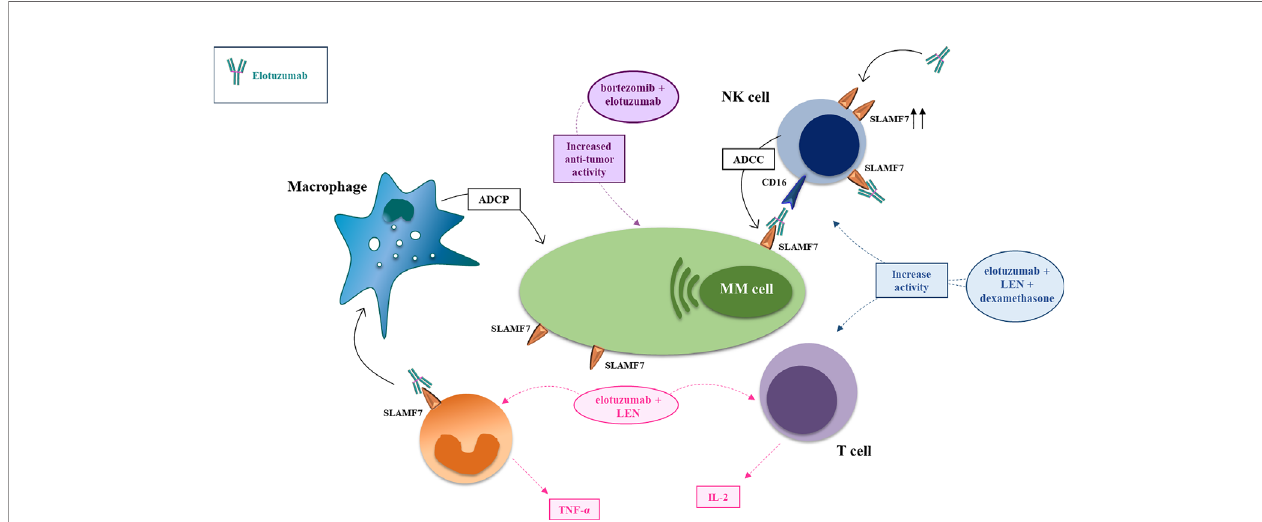
FIGURE 2 | Mechanism of action and major drug combination of the anti-SLAMF7 mAb elotuzumab. The anti-SLAMF7 mAb elotuzumab exerts anti-MM effects via several indirect mechanisms: (i) promoting macrophage-mediated antibody-dependent cellular phagocytosis (ADCP) engaging co-stimulatory signaling to enhance ADCP in macrophages expressing both SLAMF7 and EAT-2; (ii) facilitating NK cell-mediated antibody-dependent cellular cytotoxicity (ADCC) of myeloma cells through Fc-dependent interactions with CD16 (Fc g RIIIA); (iii) enhancing co-stimulatory signaling in NK cells, thereby potentiating natural cytotoxicity of myeloma cells, via simultaneous engagement of ITAM-linked activating receptors on NK cells (e.g. NKp46 or CD16) with ligands on myeloma cells; (iv) tagging myeloma cells for cell recognition; (v) elimination of immunosuppressive CD8+CD28 − CD57+ Tregs which overexpress SLAMF7. In combination with proteasome inhibitors (e.g. bortezomib, car fi lzomib) or immunomodulators (e.g. lenalidomide, pomalidomide), elotuzumab enhances anti-tumor effects via activation of T-cells and